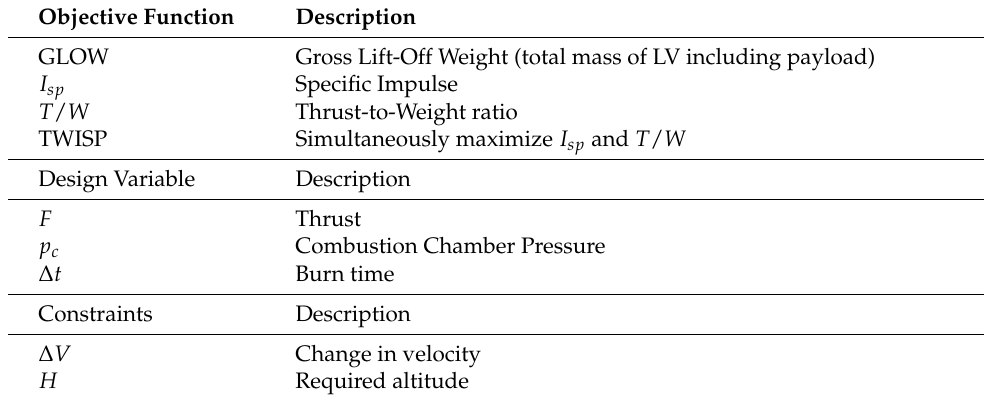
Table 2. OF and Variable names and